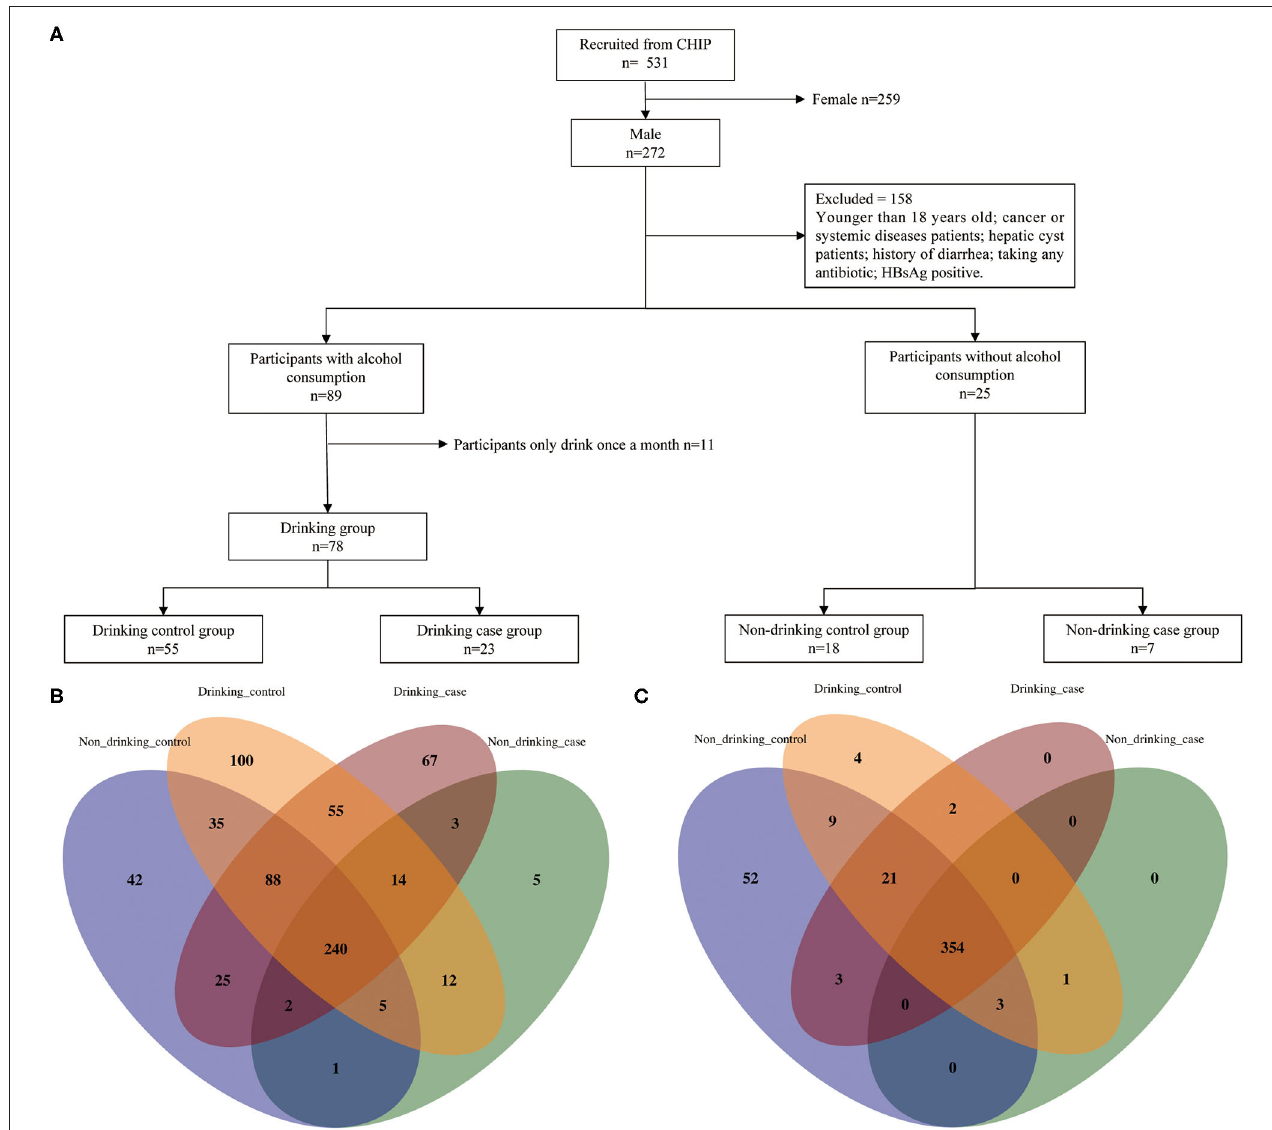
FIGURE 1 | Enrollment flow and distribution of species and metabolic pathways. (A) Enrollment flow; (B) species distribution; and (C) metabolic